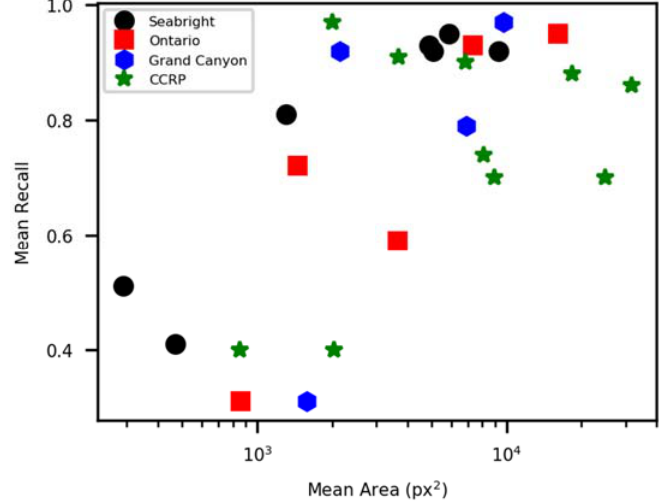
Figure 9. Average recall versus the average area (in square pixels) of classes.